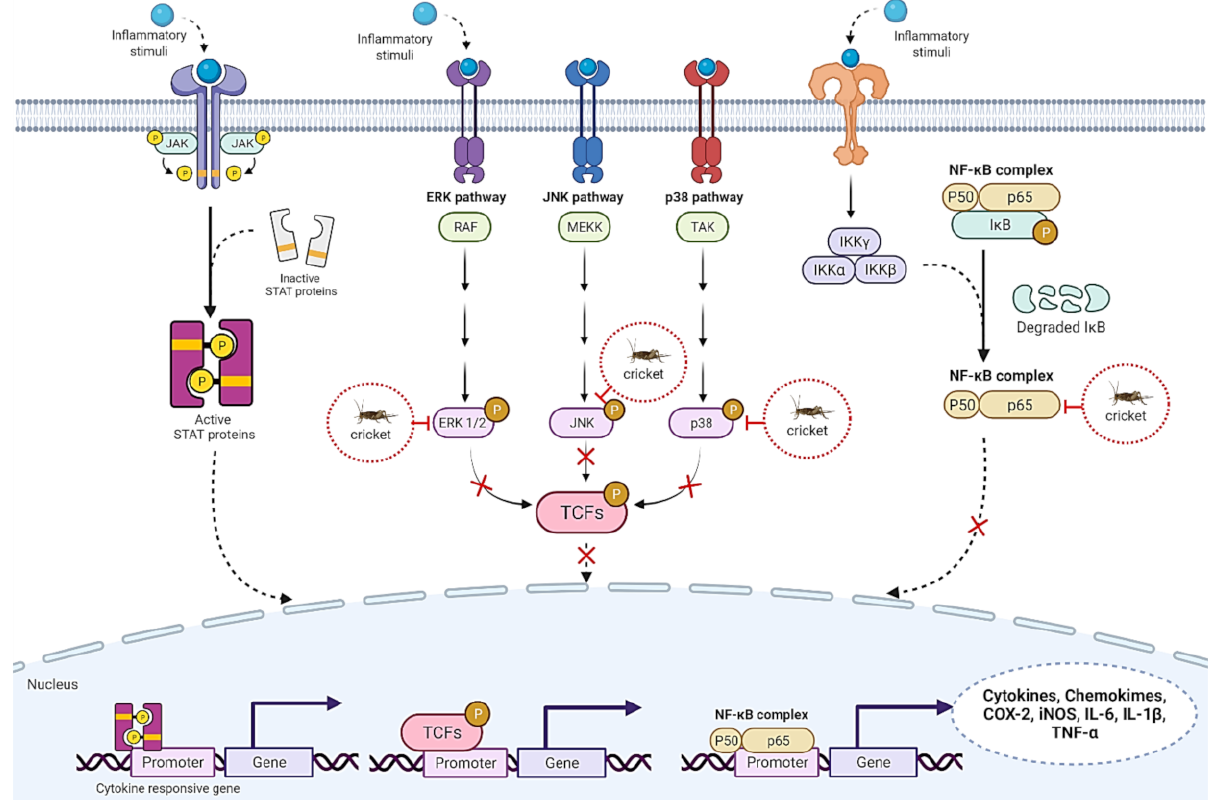
Figure 4. Inflammatory response pathway showing how crickets and their bioactive substances exhibit anti-inflammatory properties. ERK1/2: extracellular signal-regulated kinase 1/2; JNK: c-Jun N-terminal kinase; p38: p38 mitogen-activated protein kinases; TCFs: transcription factors; JAK-STAT: Janus kinase -signal transducer and activator of transcription; NF- κ B: nuclear factor kappa